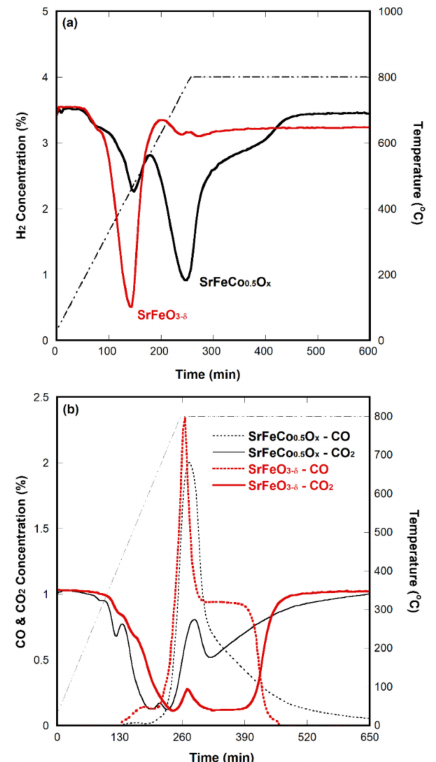
Figure 2. CO 2 decomposition results: ( a ) Consumed H 2 concentration and ( b ) CO 2 and CO concentrations during sample activation and CO 2 decomposition tests, respectively. The black lines indicate the results of SrFeCo 0.5 O x extracted from our previous work [17], and the straight dotted lines indicate temperature profiles (i.e., 3 ◦ C /